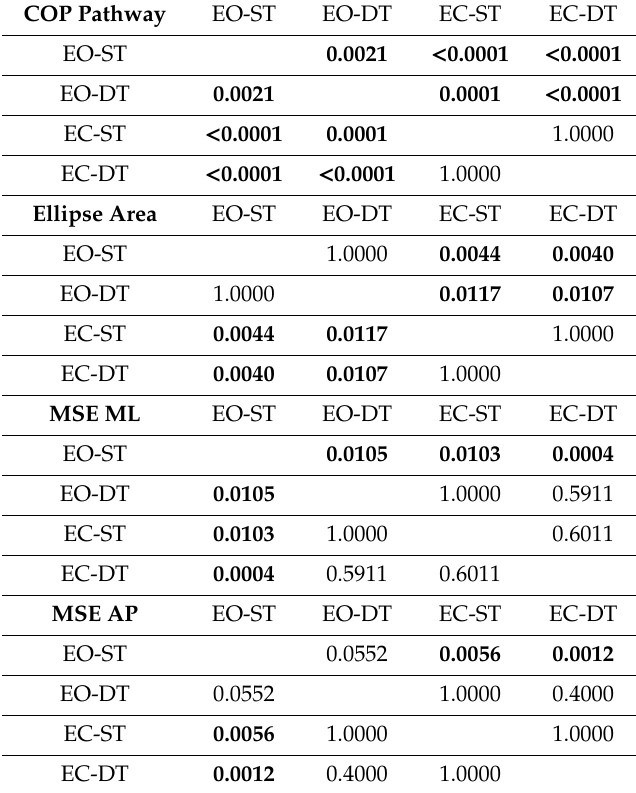
Table 3. Significant di ff erences between the four conditions in the control group using Bonferroni post hoc tests. Results are considered as significant when p <